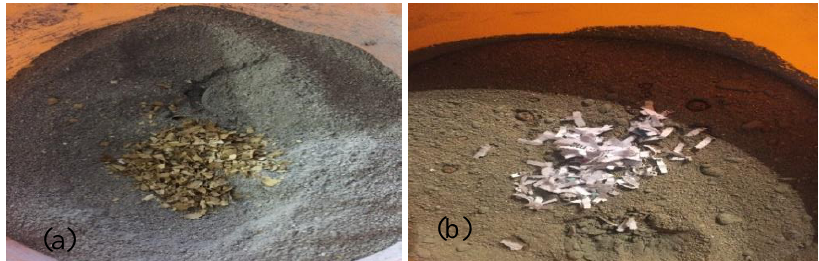
Fig. 3: Addition of waste papers to cement mortars. (a) Natural leaves (b) industrial waste paper.